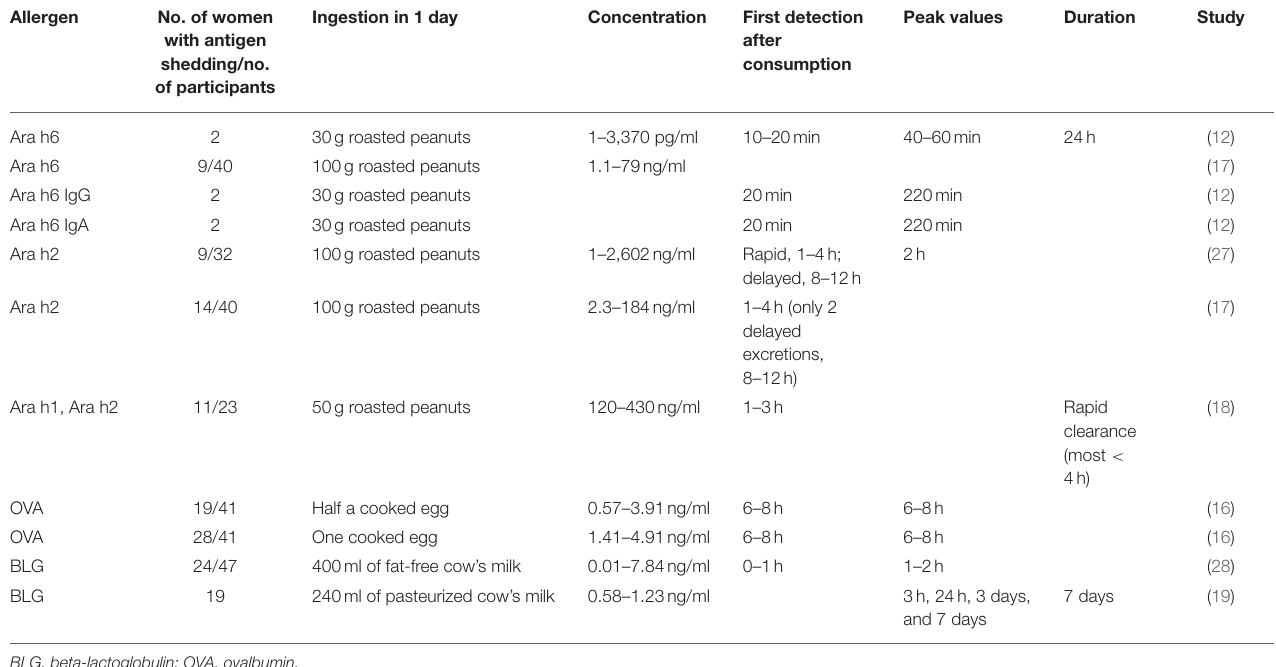
TABLE 1 | Food allergen kinetics in human milk.